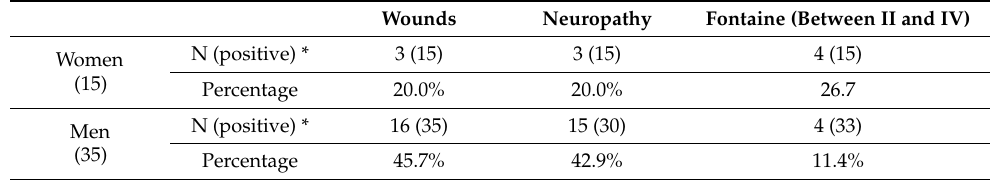
Table 2. Presence of diabetic complications included in the study, segmented according to gender. Wounds Neuropathy Fontaine (Between II and IV)